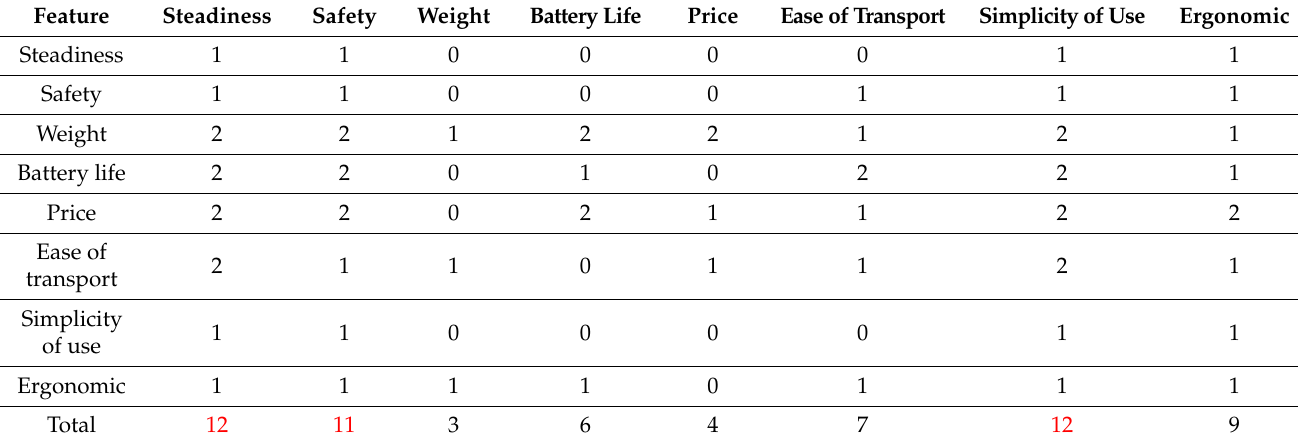
Table 4. Relationship Matrix: relative